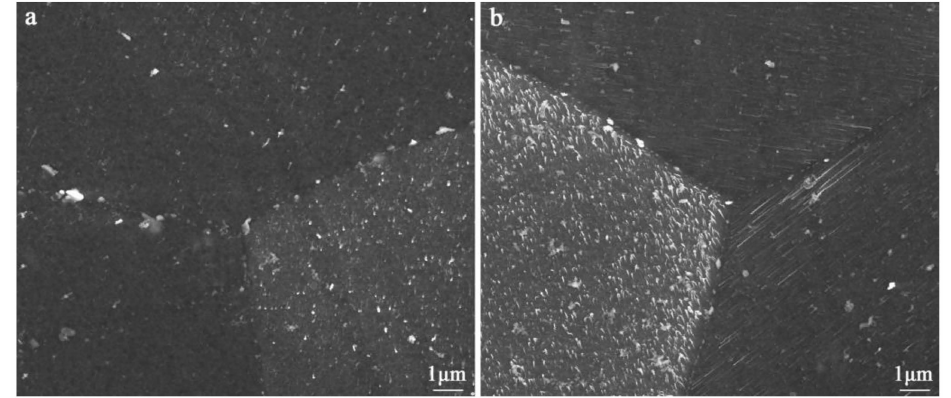
Figure 11. High-resolution SEM images of the outer surface of the ( a ) single-aged and ( b ) double-aged ZM51 alloys.